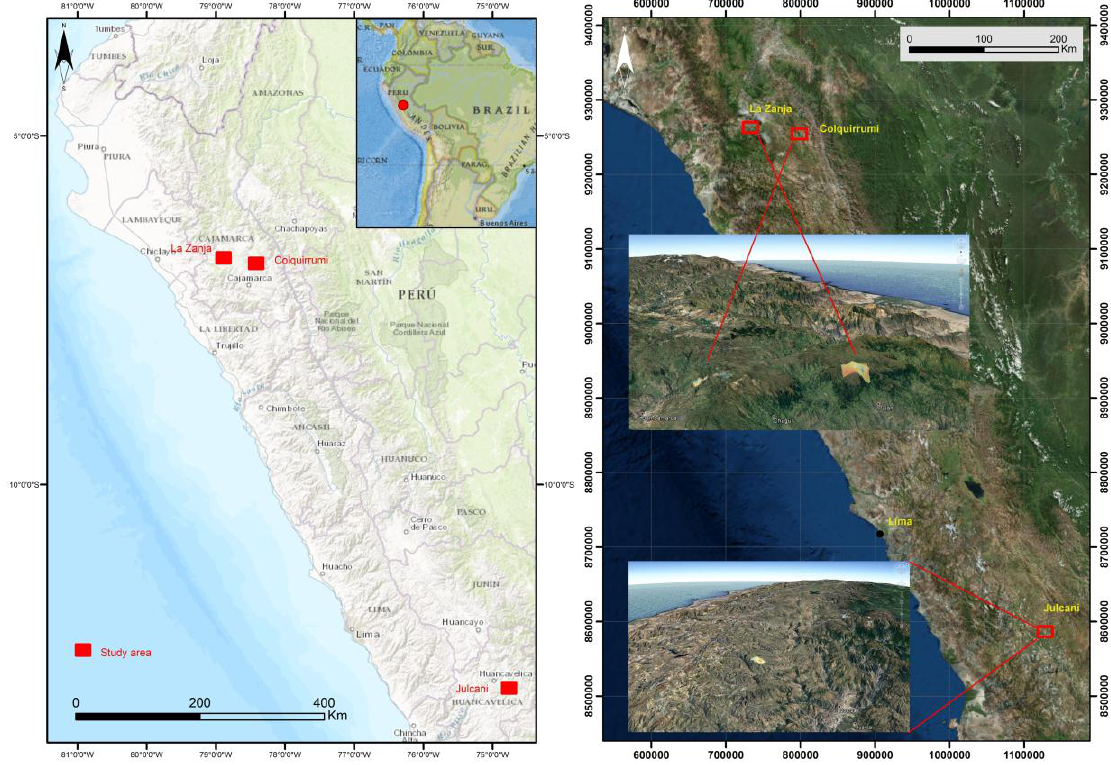
Figure 1. Situation of the study area: Cajamarca and Huancavelica.